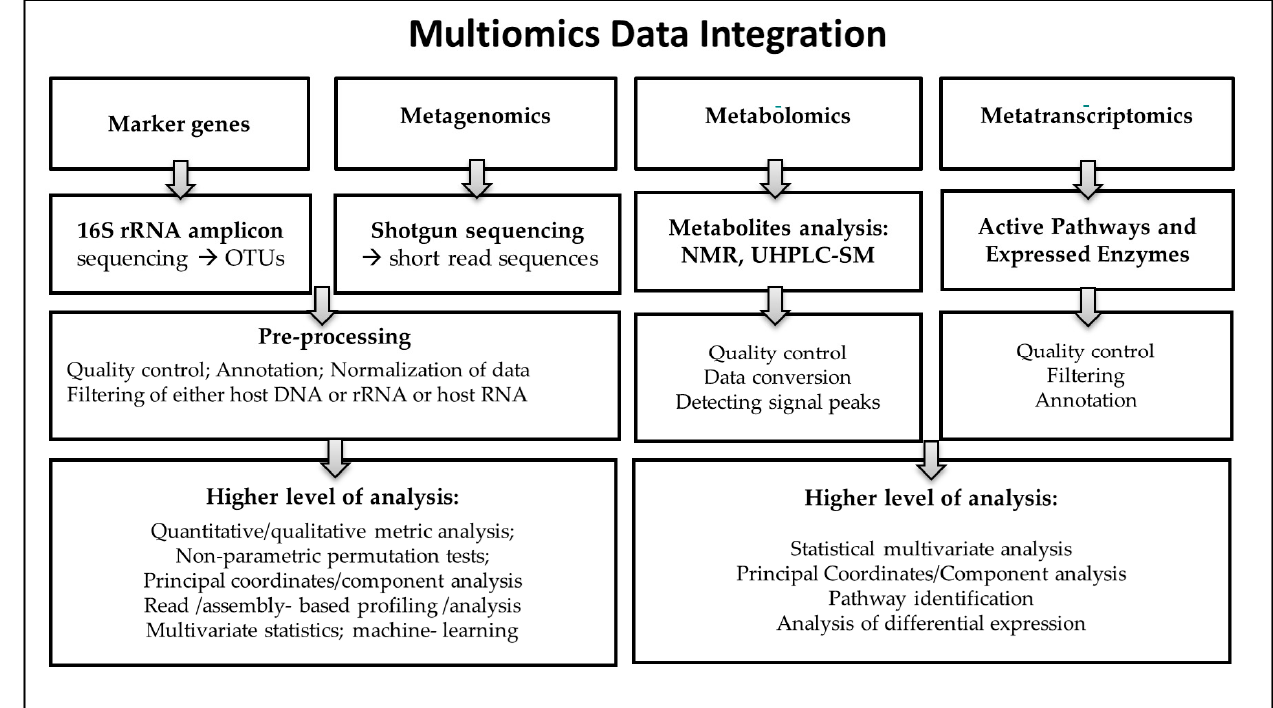
Figure 2. Multiomics and bioinformatics analysis of microbiome components.